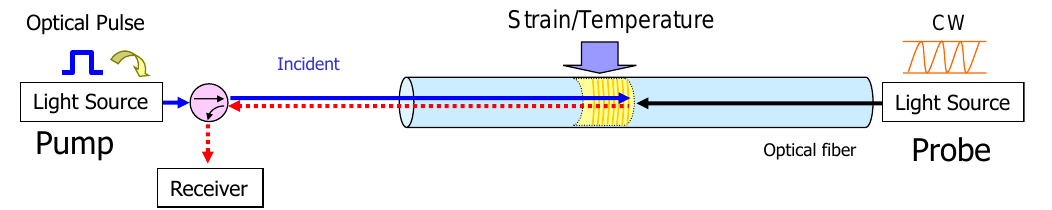
Figure 1. Brillouin time domain analysis (BOTDA) sensing scheme.